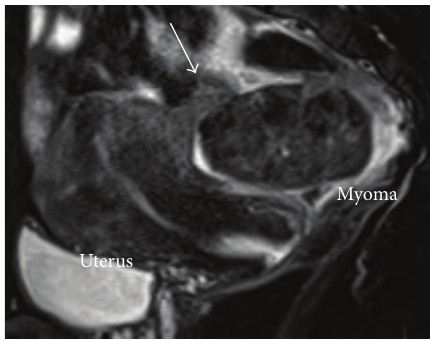
Figure 2: Sagittal T2-weighted MRI showing a torted pedicle of the subserosal myoma (arrow).